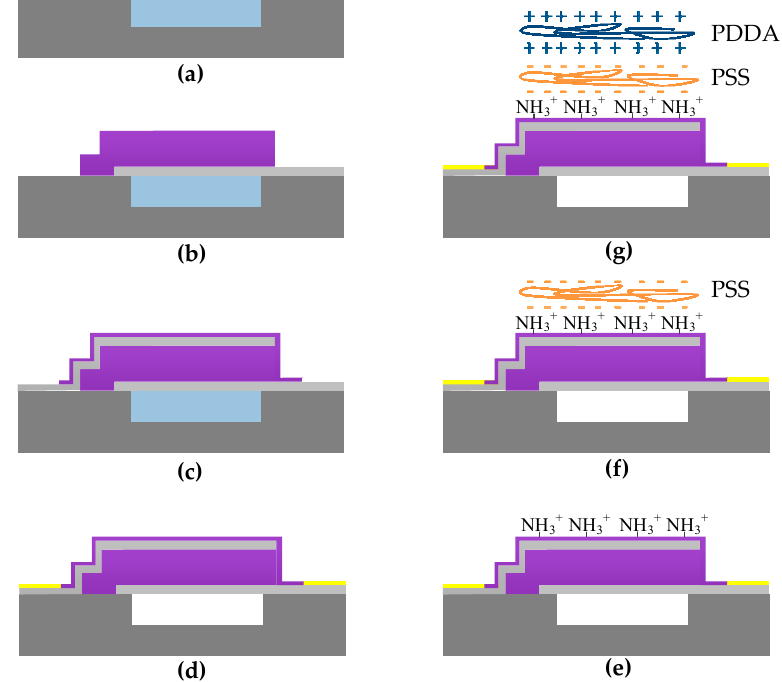
Figure 2. Schematic illustrating the fabrication process of FBAR and molecular surface self-assembly of PETs. ( a ) Etching of air cavity and deposition of phosphosilicate glass (PSG); ( b ) deposition of bottom electrode and piezoelectric layer; ( c ) deposition of top electrode and passivation layer; ( d ) deposition of Au pads and release of PSG; ( e ) amino-silanization of FBAR; ( f ) nano-assembly of poly(sodium 4-styrenesulfonate) (PSS); ( g ) nano-assembly of poly(diallyldimethytlammonium choride) (PDDA).